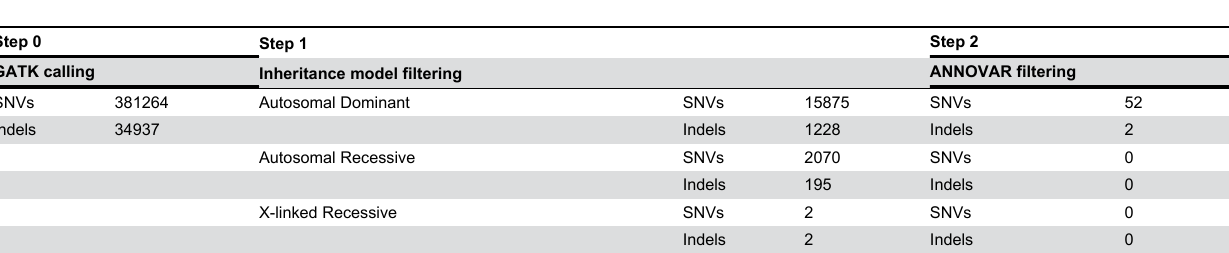
Table 3. Number of combined SNVs and Indels remaining after each filtering